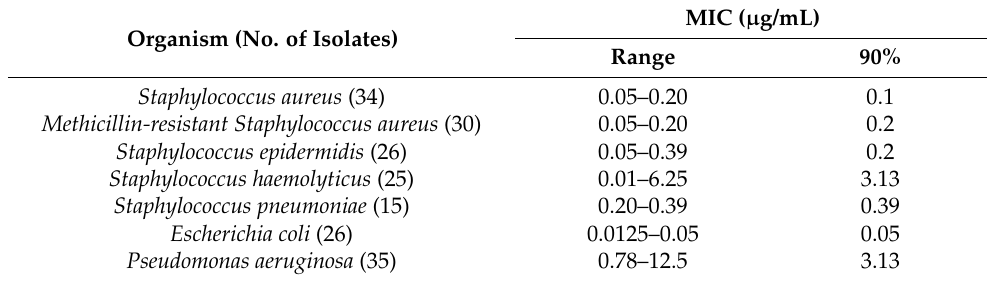
MIC ( µ g/mL) Range 90%